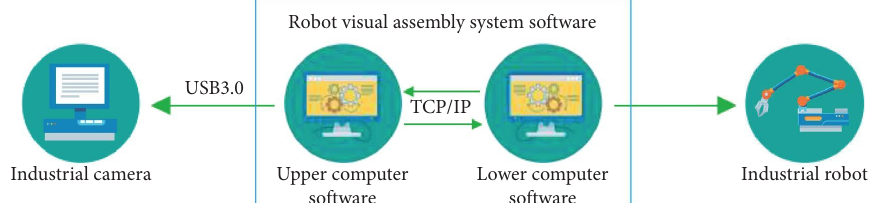
Figure 2: System software function block